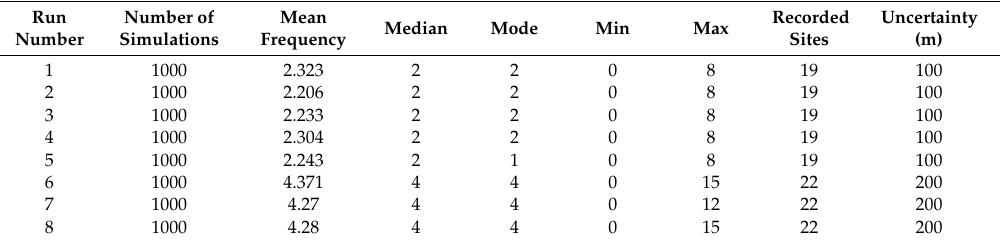
Figure 3. No. of recorded Palaeolithic sites (total n = 57) intersecting with quarries, versus number of random sites (total n = 57) intersecting with quarries, for 1000 Monte Carlo simulation runs (Run No. 1 in Table 1, below). Test No. 1001 is the 57 recorded Palaeolithic sites. Site / quarries intersection counts for Monte Carlo simulation shown in blue, recorded sites in red. Table 1. Monte Carlo Simulation test results for 8 simulation passes of 1000 runs. Note how increasing the size of the uncertainty buffer increases the number of hits for both recorded sites and randomly simulated sites.